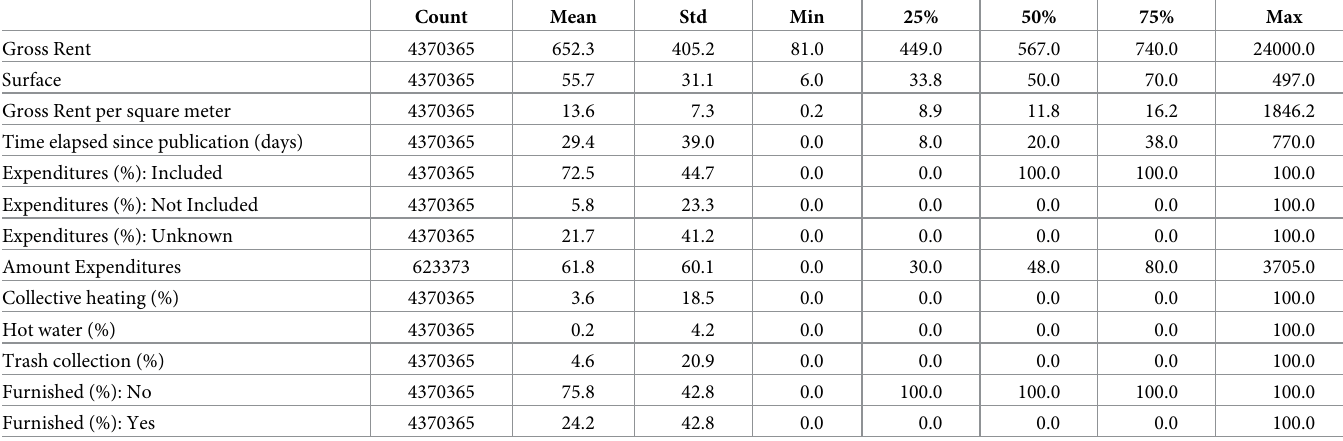
Table 2. Price, surface, expenditures and type of